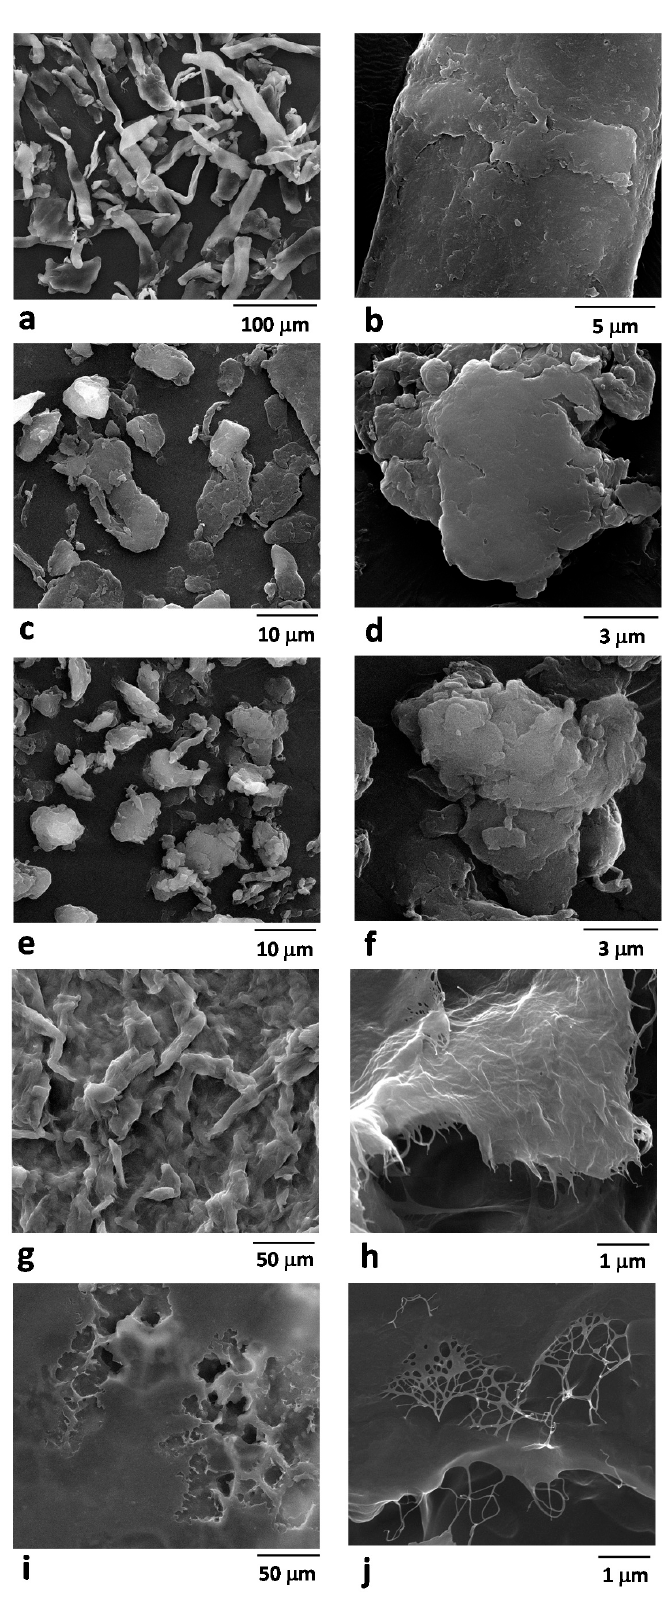
Figure 2. SEM images of ( a , b ) untreated cellulose, cellulose treated by ball milling for ( c , d ) 30 min and ( e , f ) 60 min, by ( g , h ) HPH treatment for 10 min, and ( i , j ) HPH-treated tomato pomace aque- ous